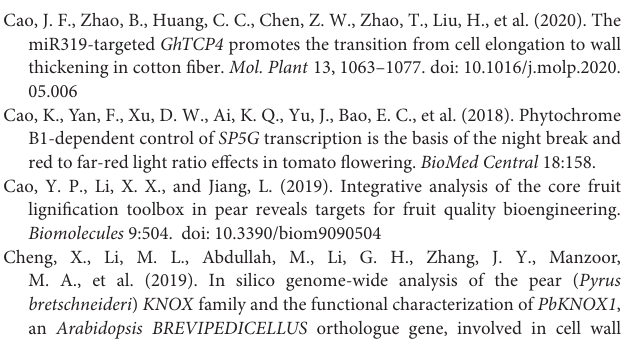
Supplementary Figure 1 | Gene Ontology (GO) analysis of TCP genes in six Rosaceae species ( Prunus mume , Rubus occidentalis , Fragaria vesca , Prunus avium , Malus domestica , Pyrus bretschneideri ). Supplementary Figure 2 | Multiple sequence alignment of pear TCP transcription factors. Alignment of the TCP domain for the predicted pear TCP proteins. The